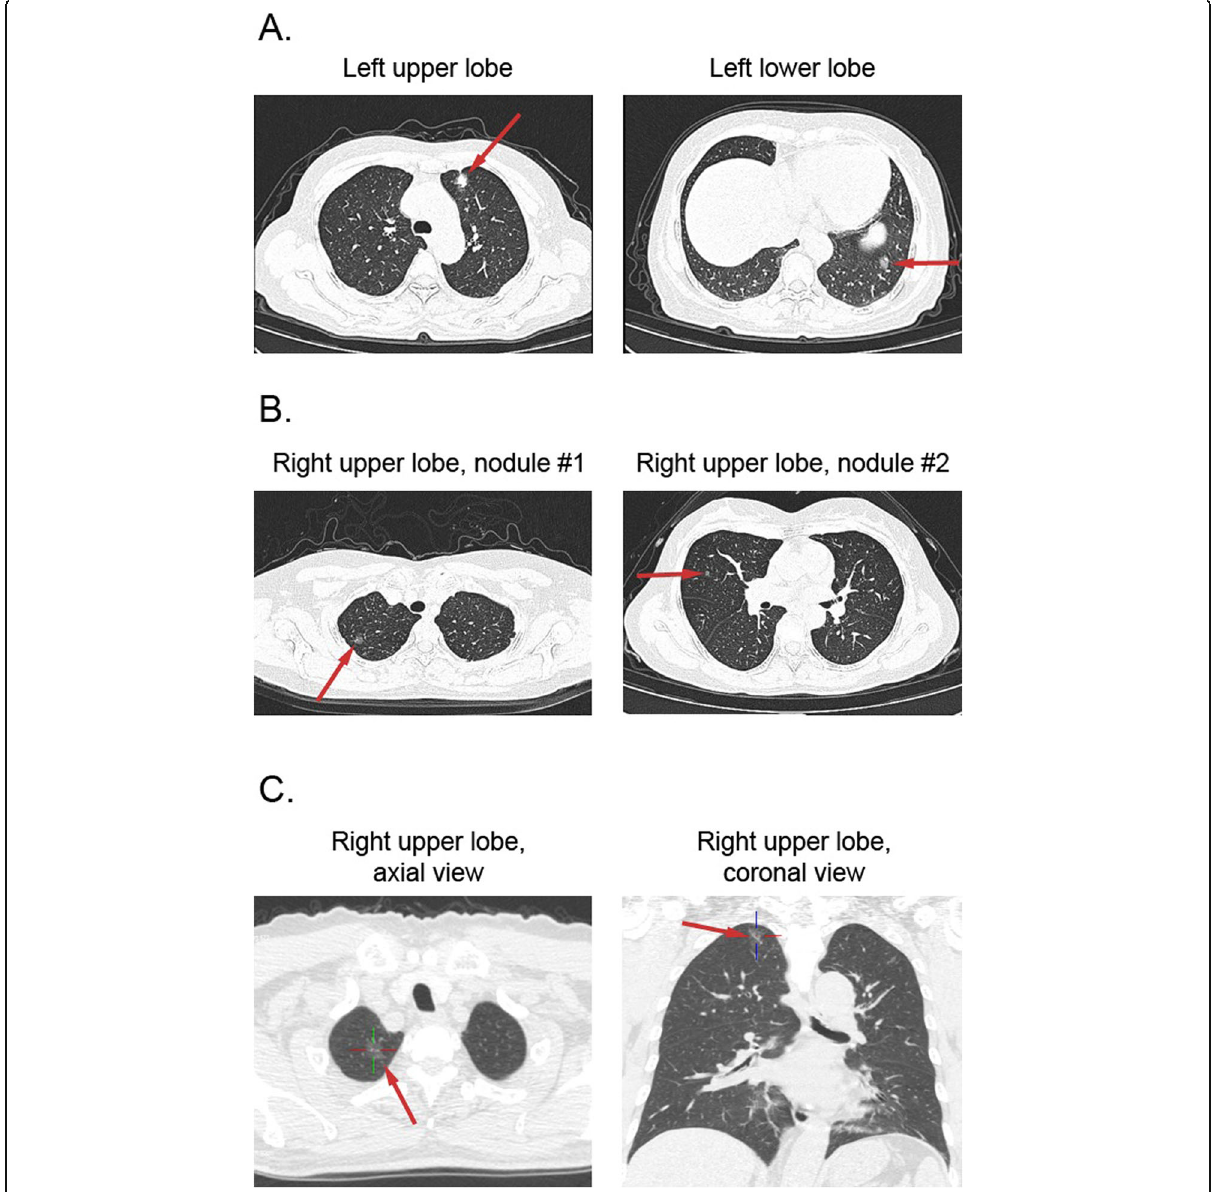
Fig. 1 Computed tomography (CT) scans showing pulmonary nodules detected in the cases presented in this series. a . In Case 1, two nodules of similar sizes (arrows) were observed in the two lobes of the left lung; b . A large number of small nodules were found in both lungs in Case 2. Shown here are two of the largest lesions; c . Transverse and frontal views of a nodule in the right upper lobe in Case 3. More miliary micronodules, although not readily discernable in CT scans, were discovered during surgical removal of this